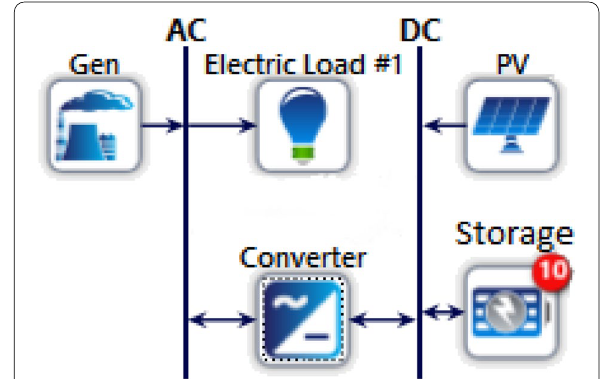
Fig. 1 Simulated power system in HOMER Pro